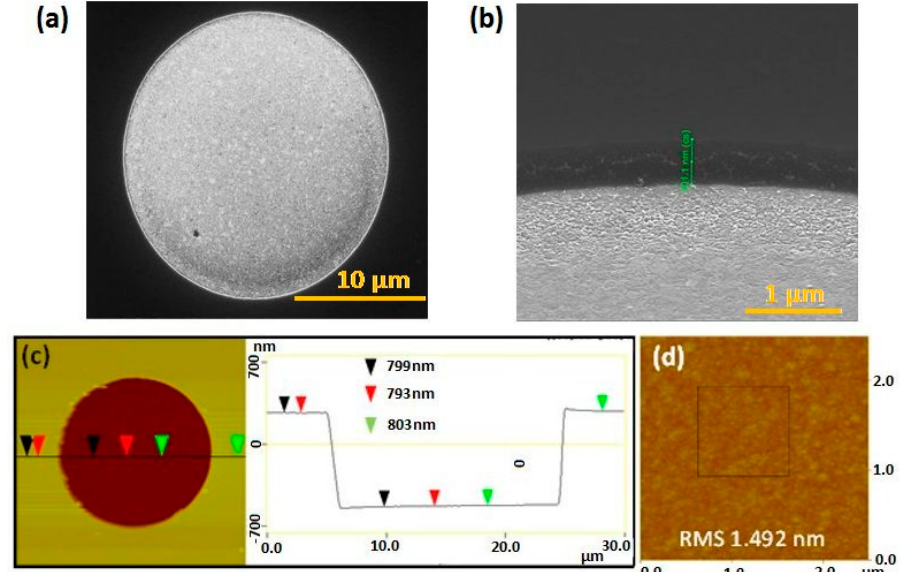
Figure 2. ( a ) Plan view SEM image; ( b ) tilted side view SEM image of an individual gold microdisc; ( c ) AFM micrograph and corresponding topographical section analysis; ( d ) AFM micrograph for roughness analysis.